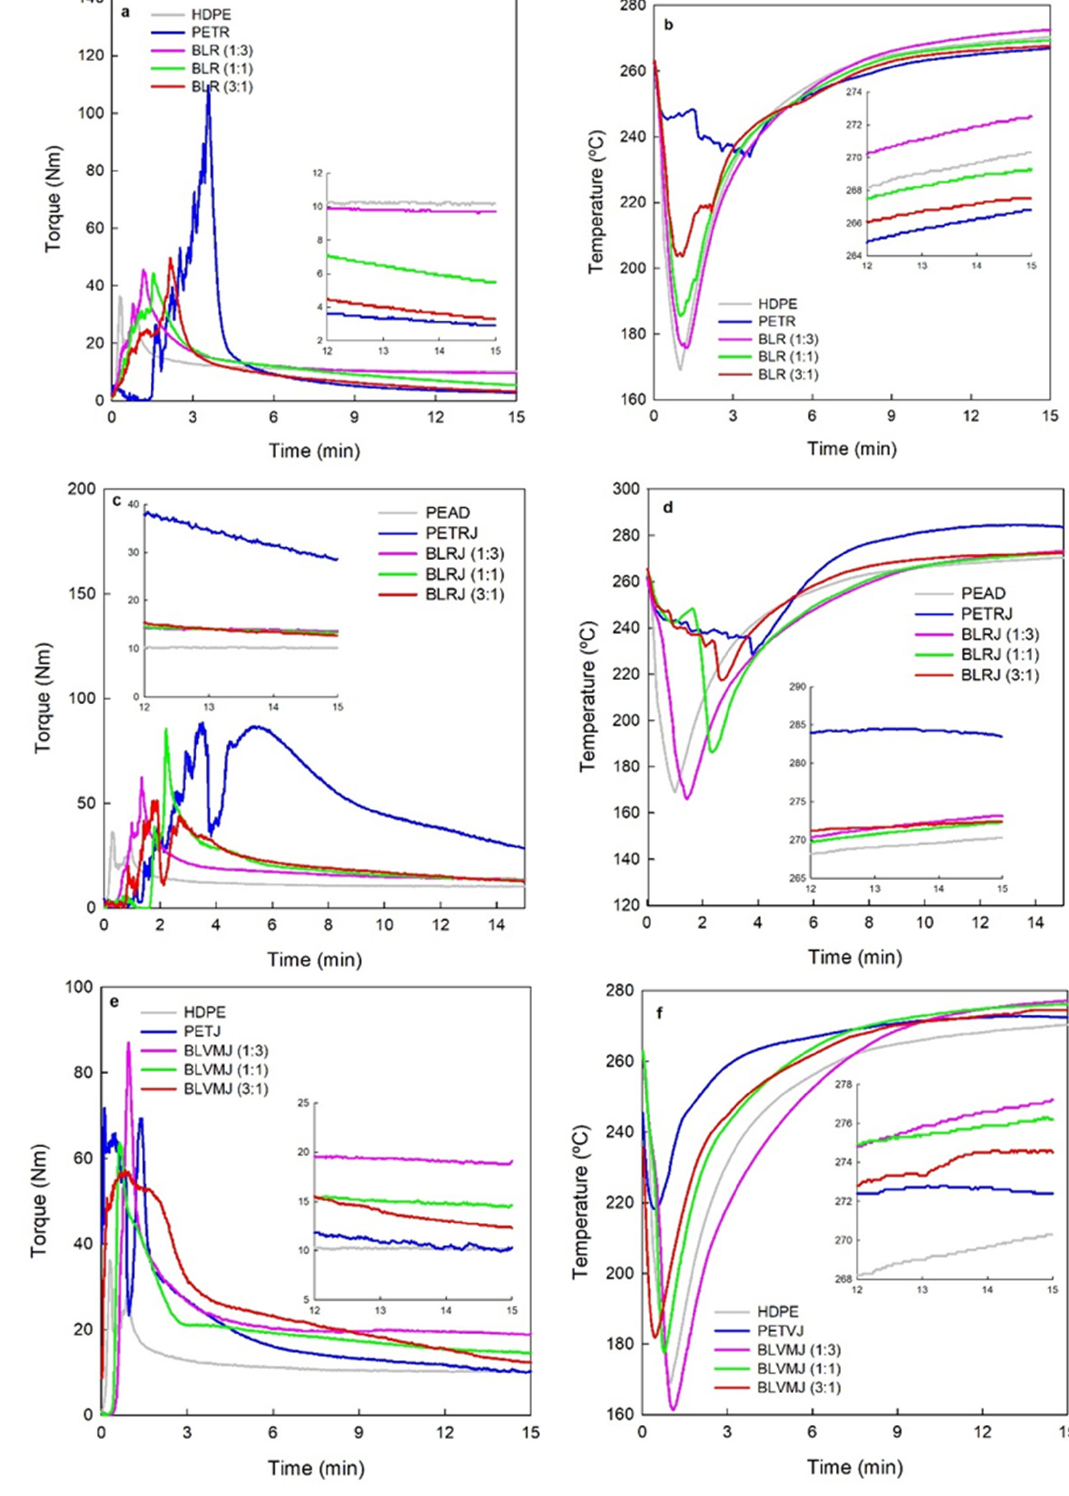
Figure 1. Torque ( a , c , e ) and temperature ( b , d , f ) as functions of time for the neat polymers and their blends containing neat ( a , b ), additivated ( c , d ) and additivated and compatibilized ( e , f ) PETR processed at 265 °C, 60 rpm for 15 min.